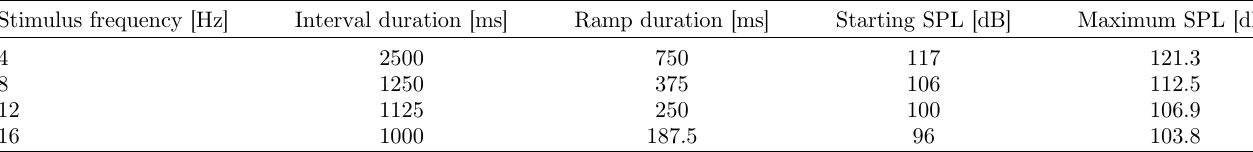
Table 1. Parameters of stimuli used for threshold